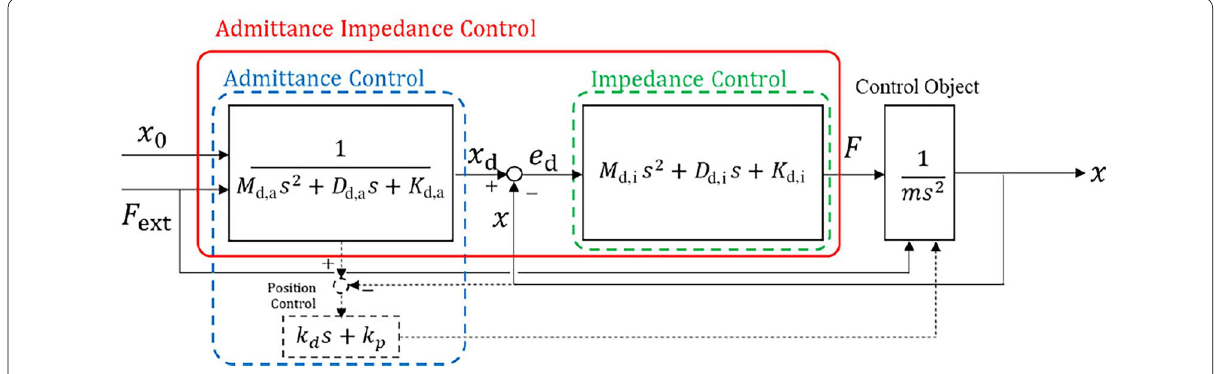
Fig. 2 Block diagram of the proposed